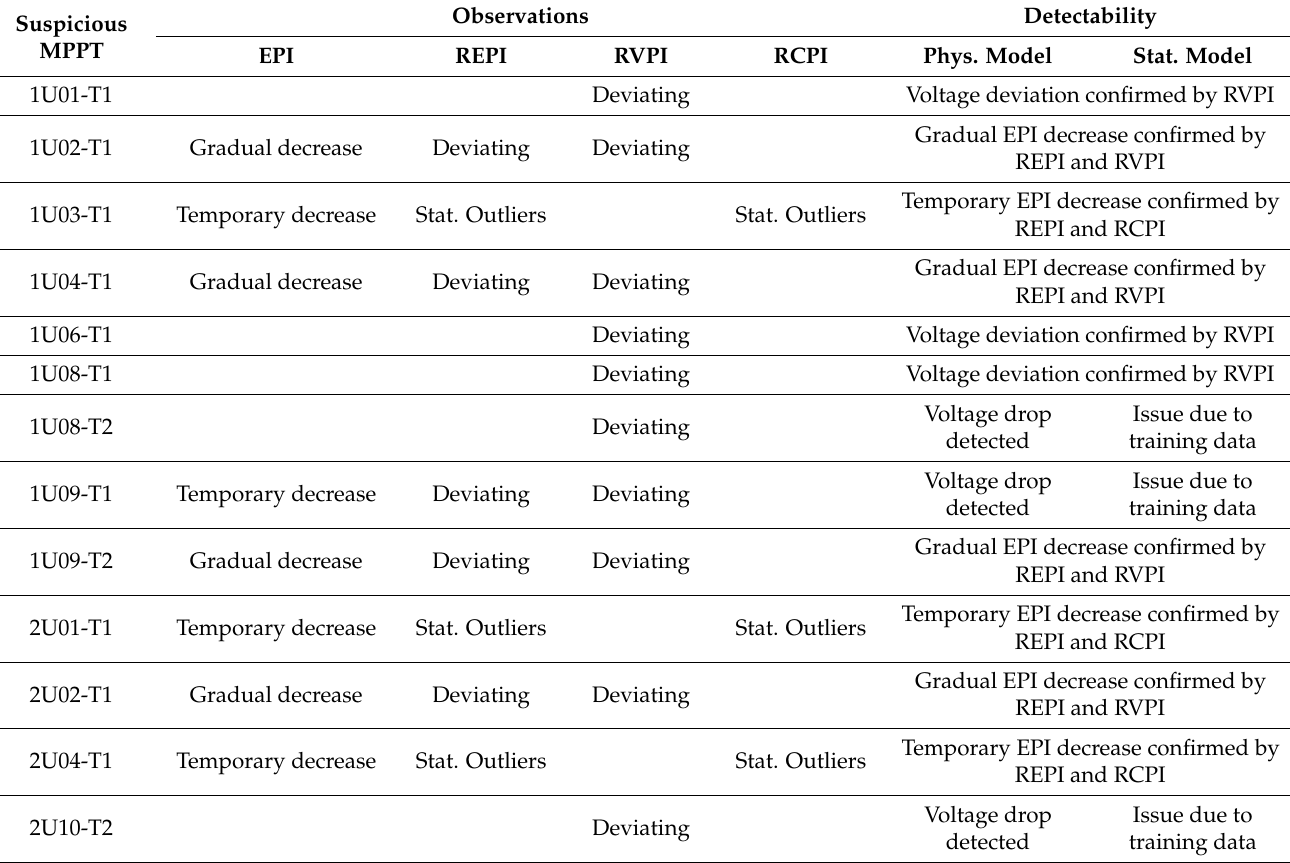
Table 3. Comparison of model-based monitoring